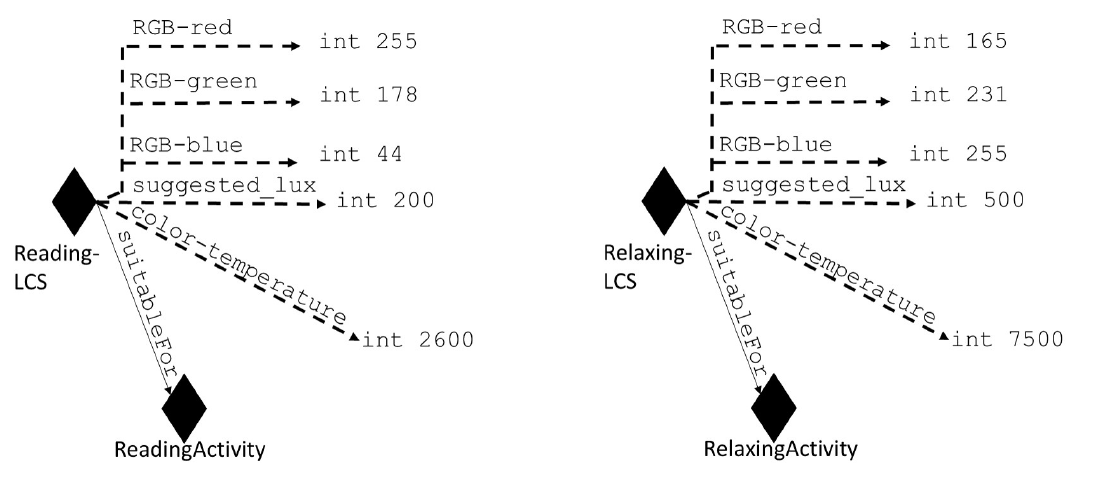
Figure 11. The modelling of the two Luminous Comfort Setting (LCS) deriving from the tests conducted on luminous comfort evaluation. Individuals are represented with diamonds, concepts are represented with circles, and roles are represented with arrows (dashed arrows indicate datatype